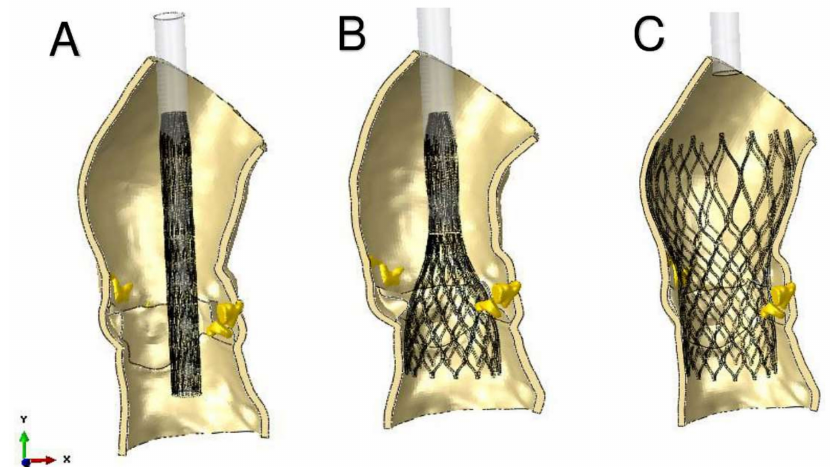
Figure 6. Main steps of simulation of TAVR using finite element analysis investigation. Catheter model has rigid material properties. ( A ) stent crimping; ( B ) catheter removing; ( C ) stent